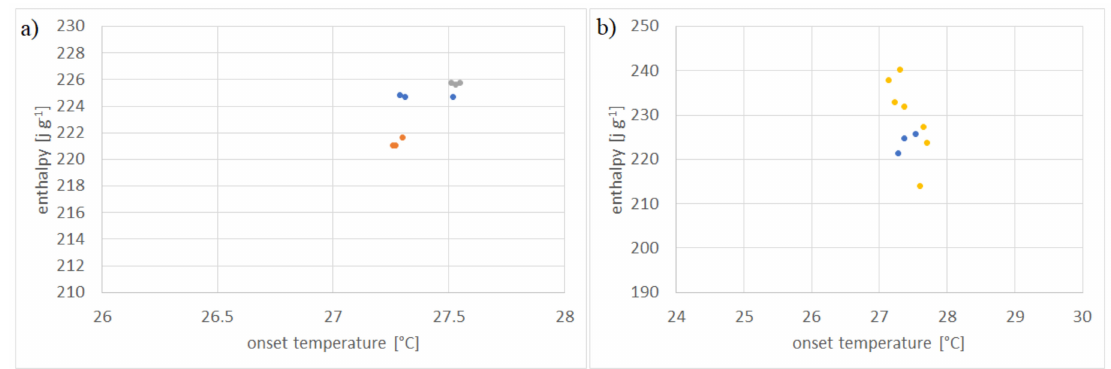
Figure 6. ( a ) Experimental results of enthalpy over onset temperature of Parafol 18-97 (octadecane) measured three times, as per measurement protocol suggested in Section 2.3. Each color depicts one measurement run. ( b ) Comparison of mean enthalpy and onset temperature from measurements (blue) with published data on standard DSC technique (yellow)